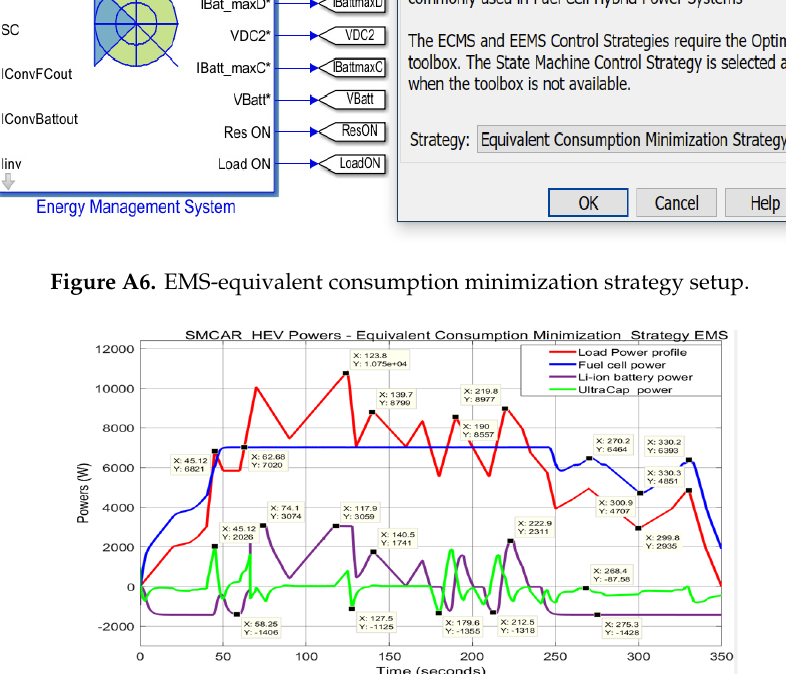
Figure A7. SMCAR HEV power-equivalent consumption minimization EMS.